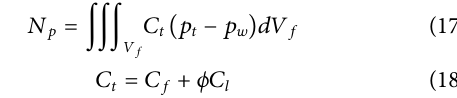
Frontiers in Energy Research |